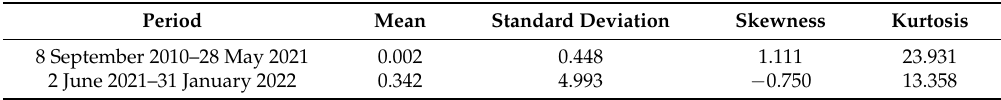
Figure 3. Historical TTF Front Month prices. Table 1. Summary of price